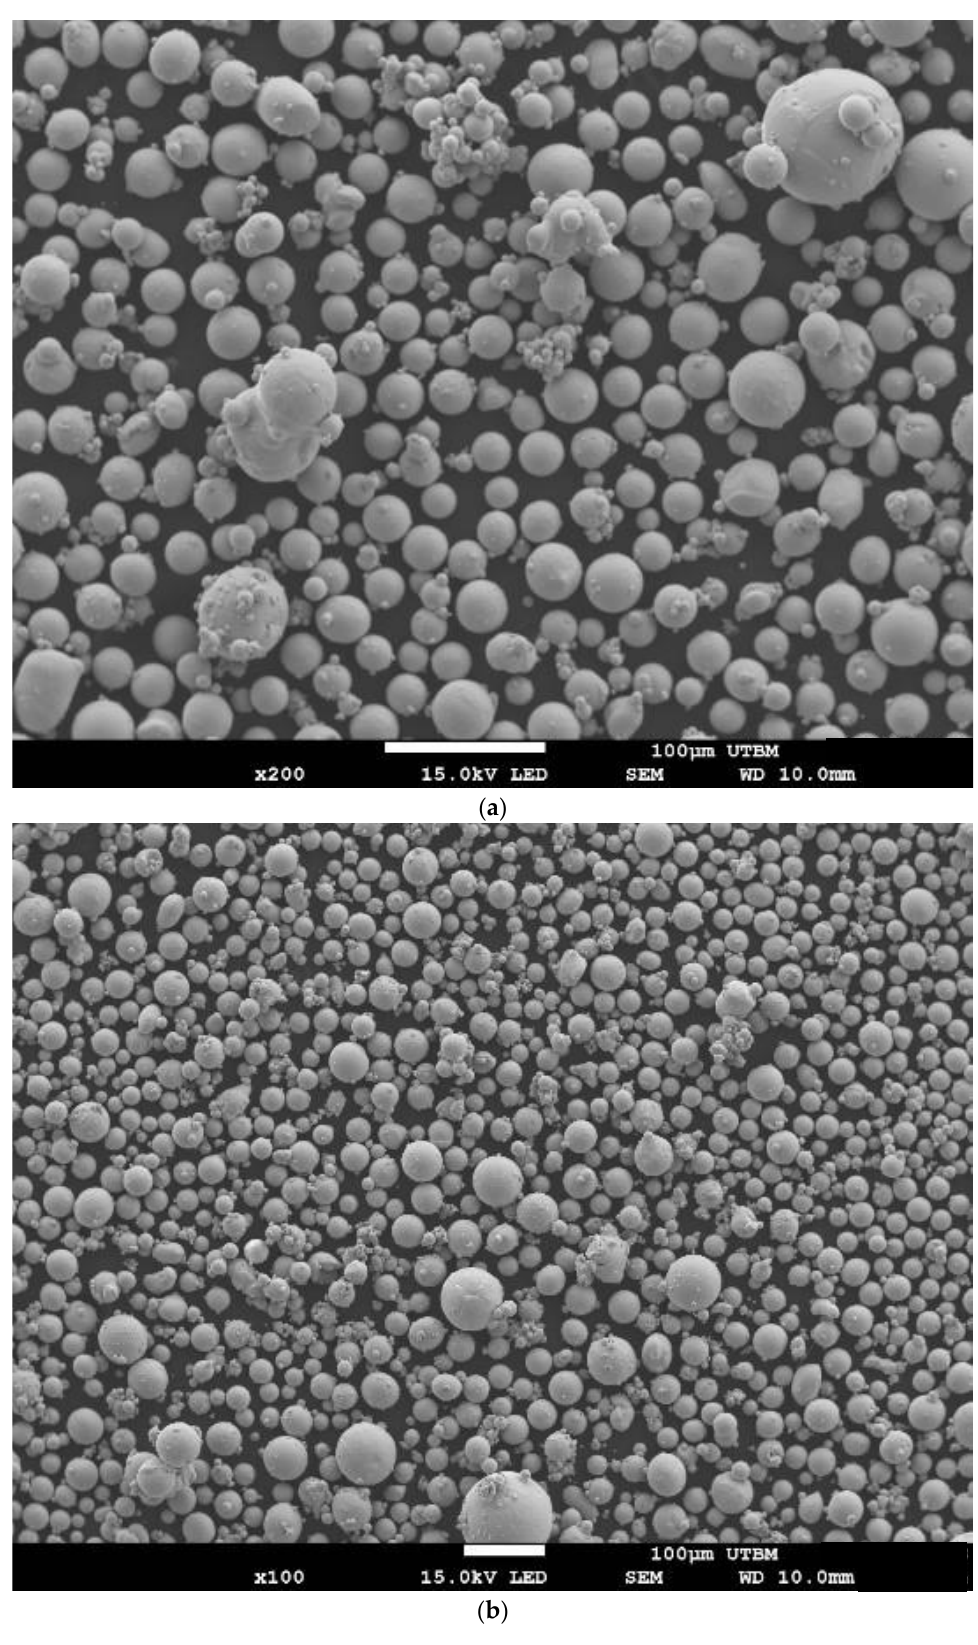
Figure 2. Surface morphologies of the Cu powders: 17 – 44 µm sized powders ( a ), and 15 – 33 µm sized powders ( b ).